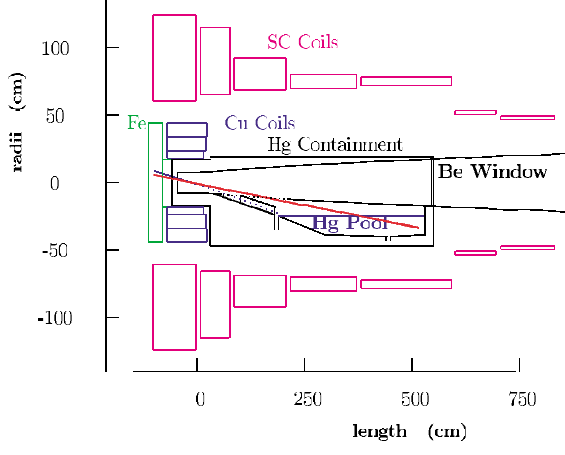
FIG. 14. (Color) Target, capture solenoids, and mercury